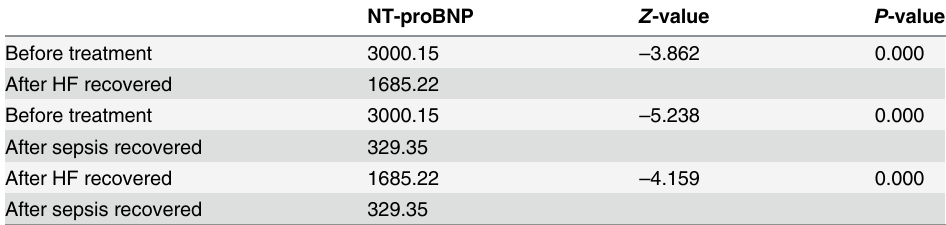
Table 4. Comparison of plasma NT-proBNP levels before treament and after HF and sepsis recovery, ng/L. NT-proBNP Z -value P -value Before treatment 3000.15 – 3.862 0.000 After HF recovered